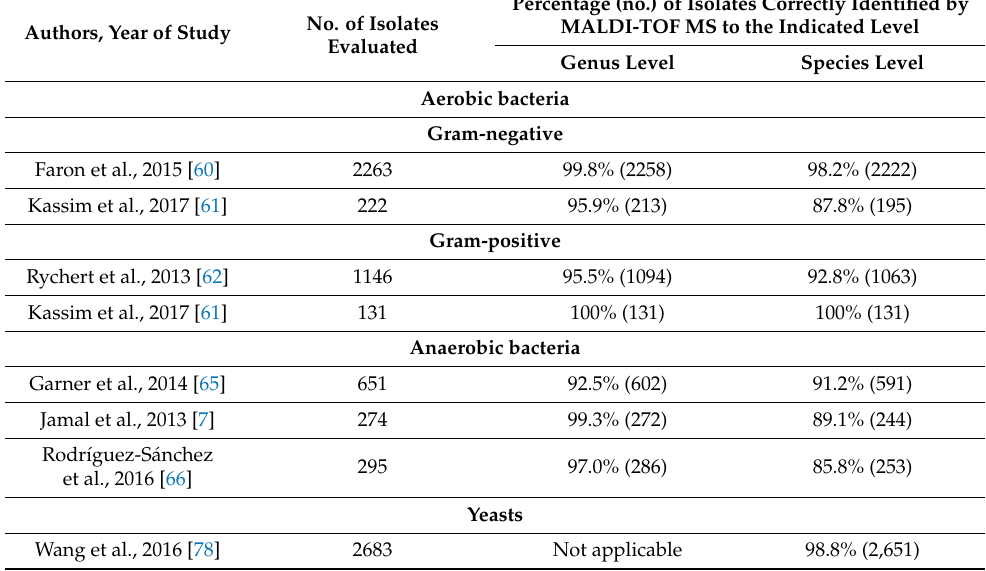
Table 1. Performance of MALDI-TOF MS for the identification of